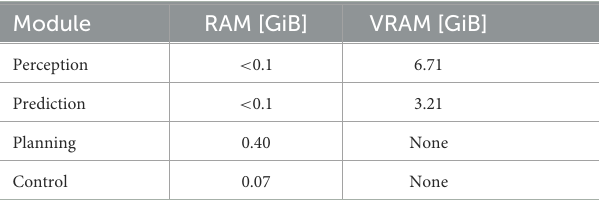
TABLE 1 Resource consumption per Apollo module in terms of a RAM and video